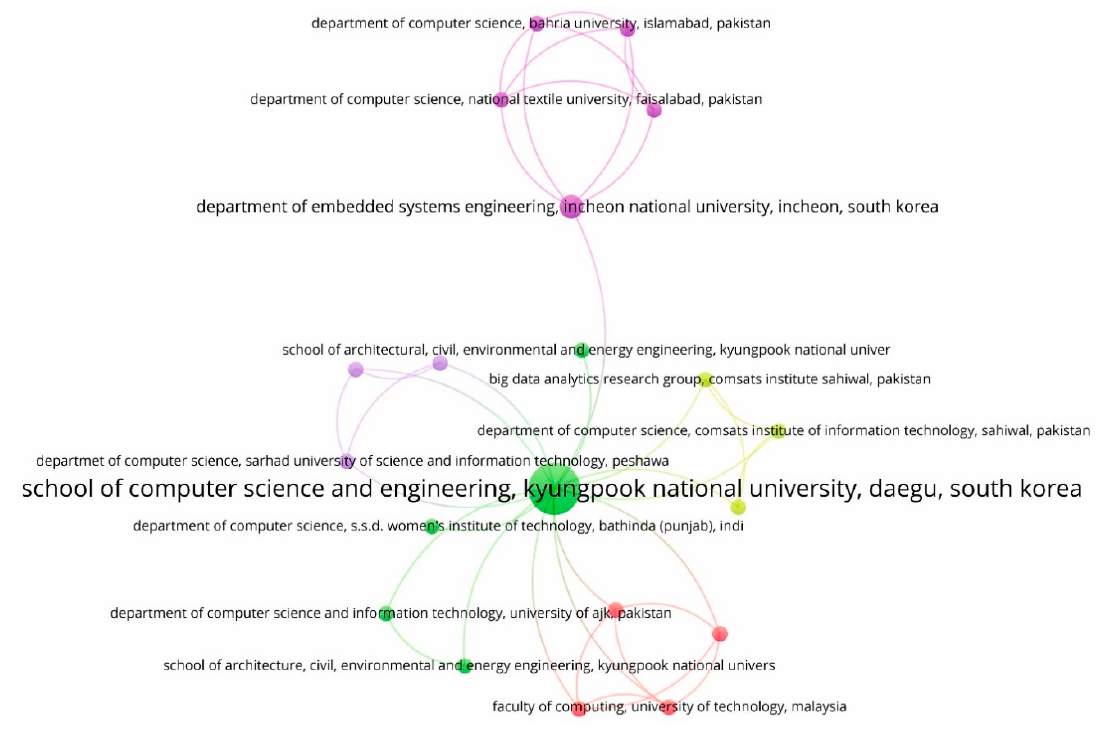
Figure 6. Research Institutions network based on the co-authorship method (2011–2019).